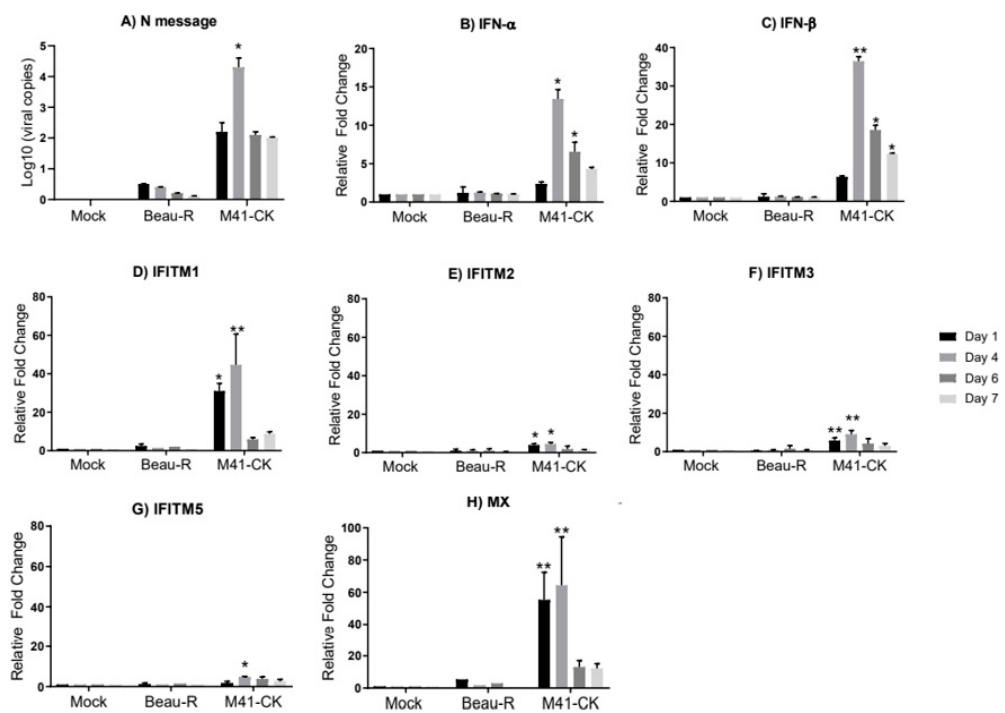
Figure 1. Expression of IFNs and chIFITMs are upregulated in the trachea of chickens in response to M41-CK infection but not to Beau-R infection. ( A ) Log 10 of infectious bronchitis virus (IBV) RNA copies in tracheas from chickens infected with Beau-R and M41-CK. The IBV genome loads were determined using absolute quantification. Relative mRNA expression of ( B ) IFN- α , ( C ) IFN- β , ( D – G ) chIFITM1 , 2 , 3 and 5 and ( H ) Mx in trachea from chickens infected with pathogenic M41-CK and nonpathogenic Beau-R strain of IBV were analyzed for gene expression at 1, 4, 6 and 7 days post infection (dpi). Relative mRNA expression was determined by real-time PCR normalized to two reference genes RPLPO and RPL13 . All graph values are the mean of three biological replicates with error bars as standard deviation; * indicates p < 0.05, ** indicates p < 0.01 ANOVA data were corrected for multiple comparisons using the Bonferroni adjustment method (GraphPad).